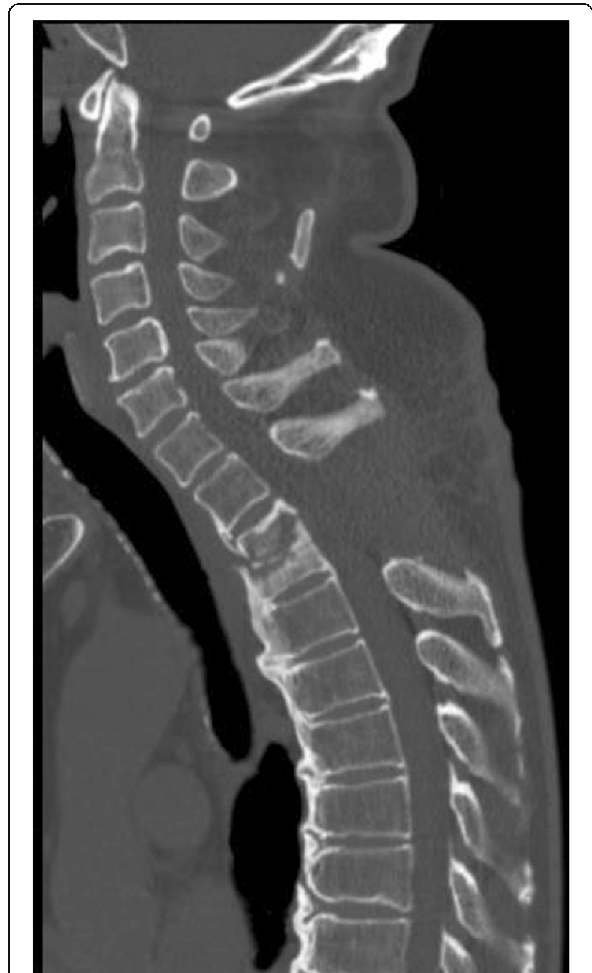
Fig. 4 Laminectomy of Th2 – 3 was performed. Osteolytic change was observed in the Th2 – 3 vertebral